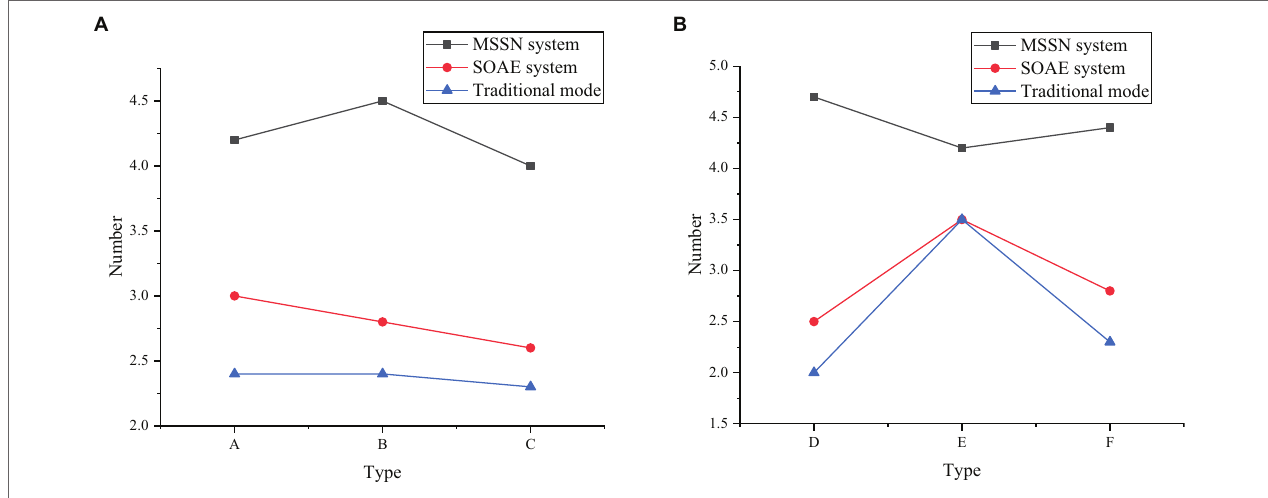
FIGURE 6 | Test results of oral English teaching in knowledge learning [ (A) : students; (B) : teachers; A: Interest; B: Exploratory; C: learning mastery; D: students’ interest in learning; E: key content explanation; F: student